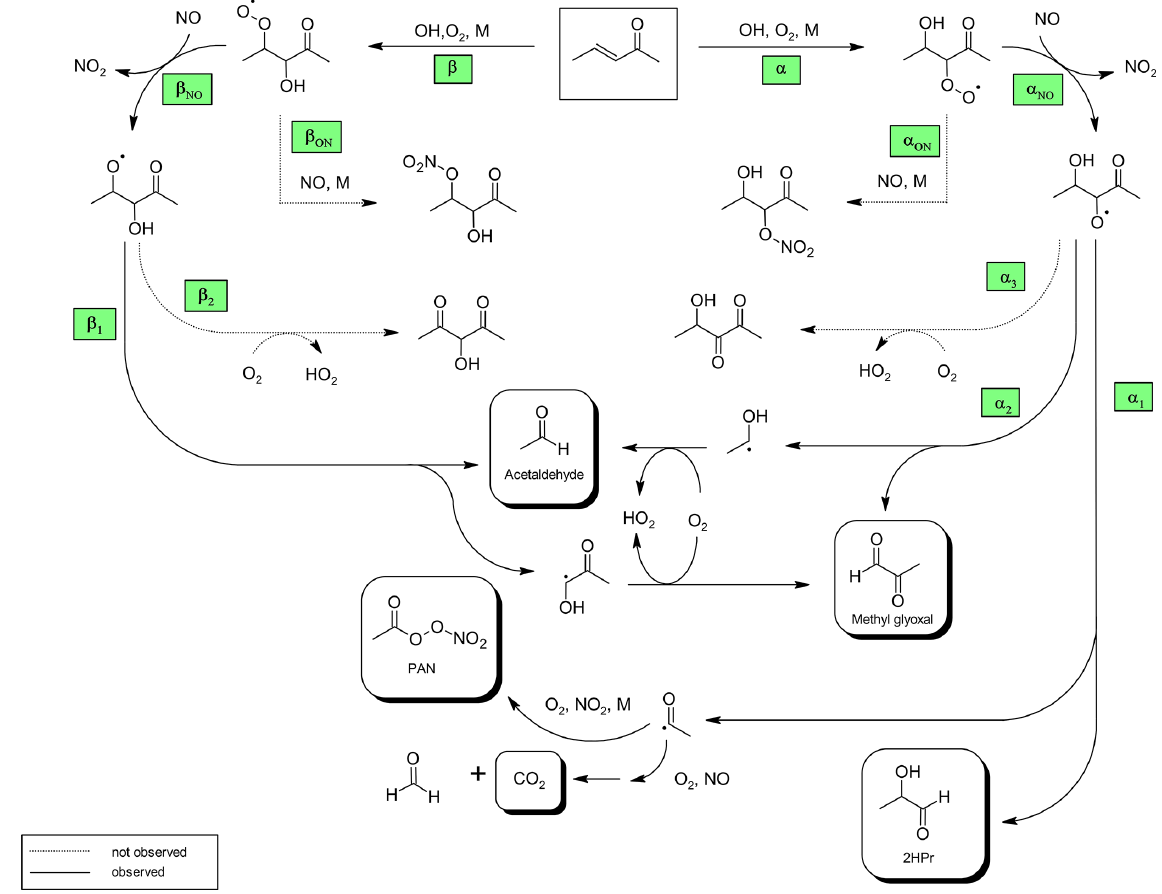
Figure 4. Proposed mechanism for the OH-radical-initiated oxidation of 3P2. The reaction pathways are named according to the position where the oxygen adds to form the peroxy